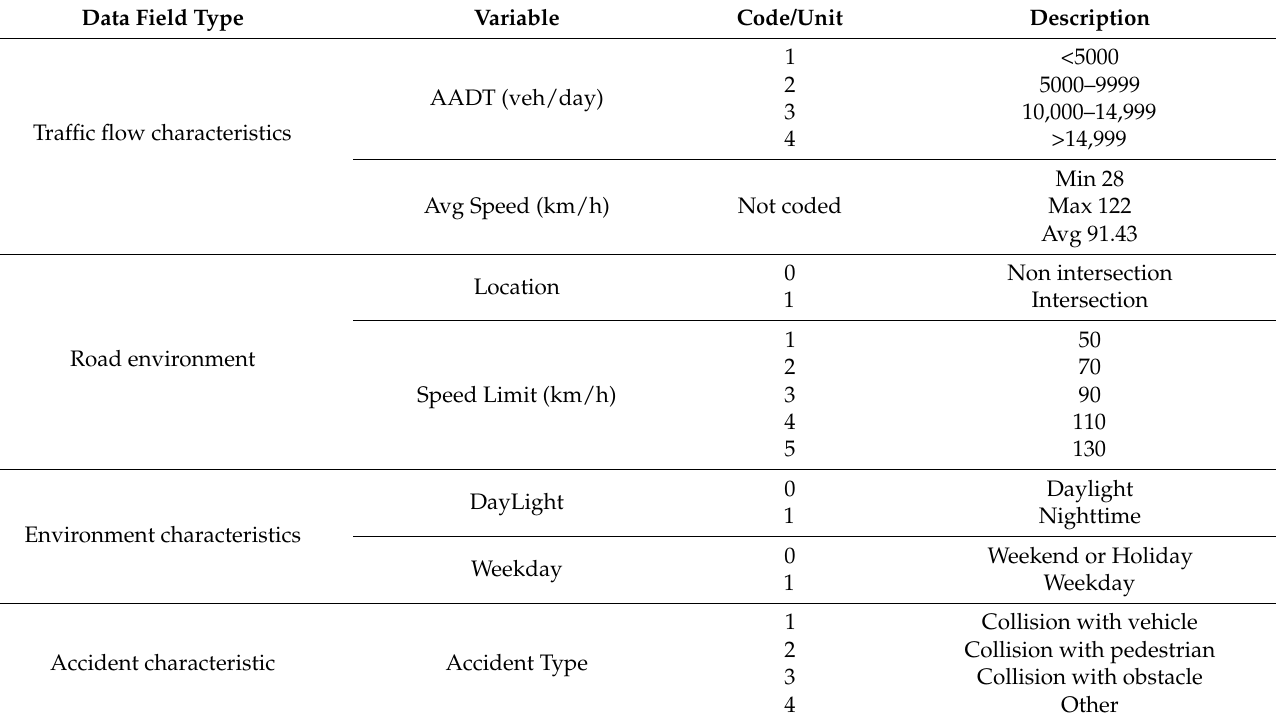
Table 2. Independent variables (qualitative and